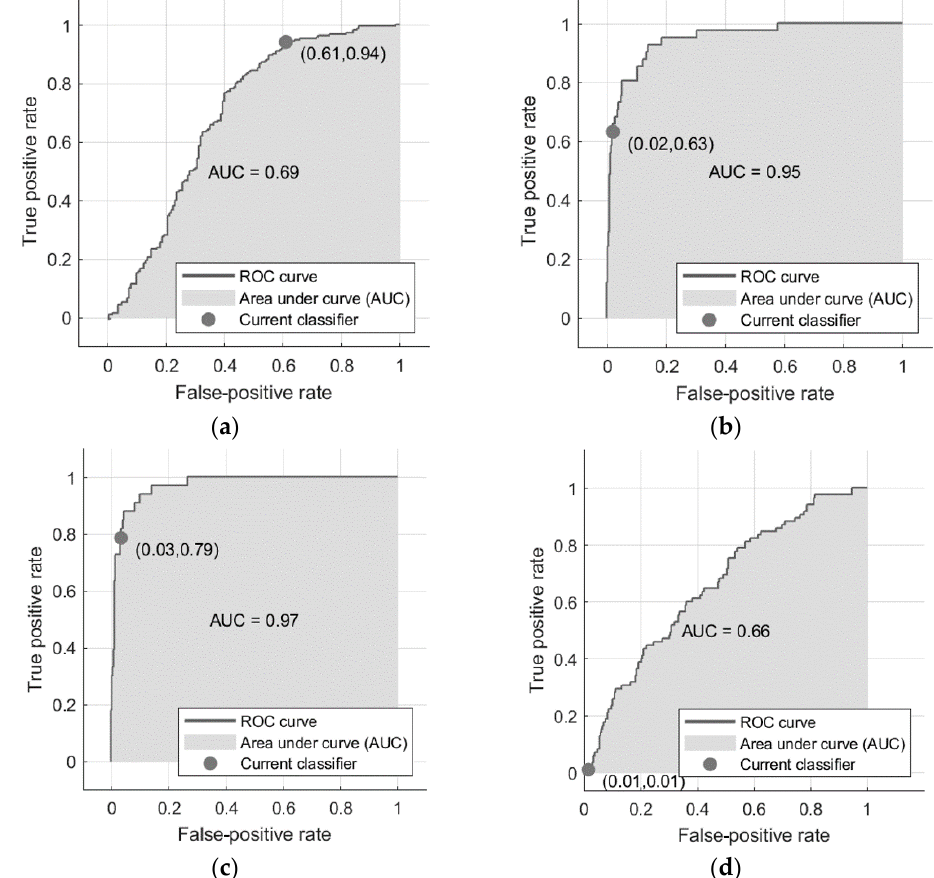
Figure 7. ROC curves of the classification algorithm with the best accuracy (linear SVM) after the feature selection process. ( a ) Cable insulation failure vs all other classes; ( b ) excavation damage vs. all other classes; ( c ) secondary substation busbar failure vs. all other classes; ( d ) joint failure vs. all other classes.